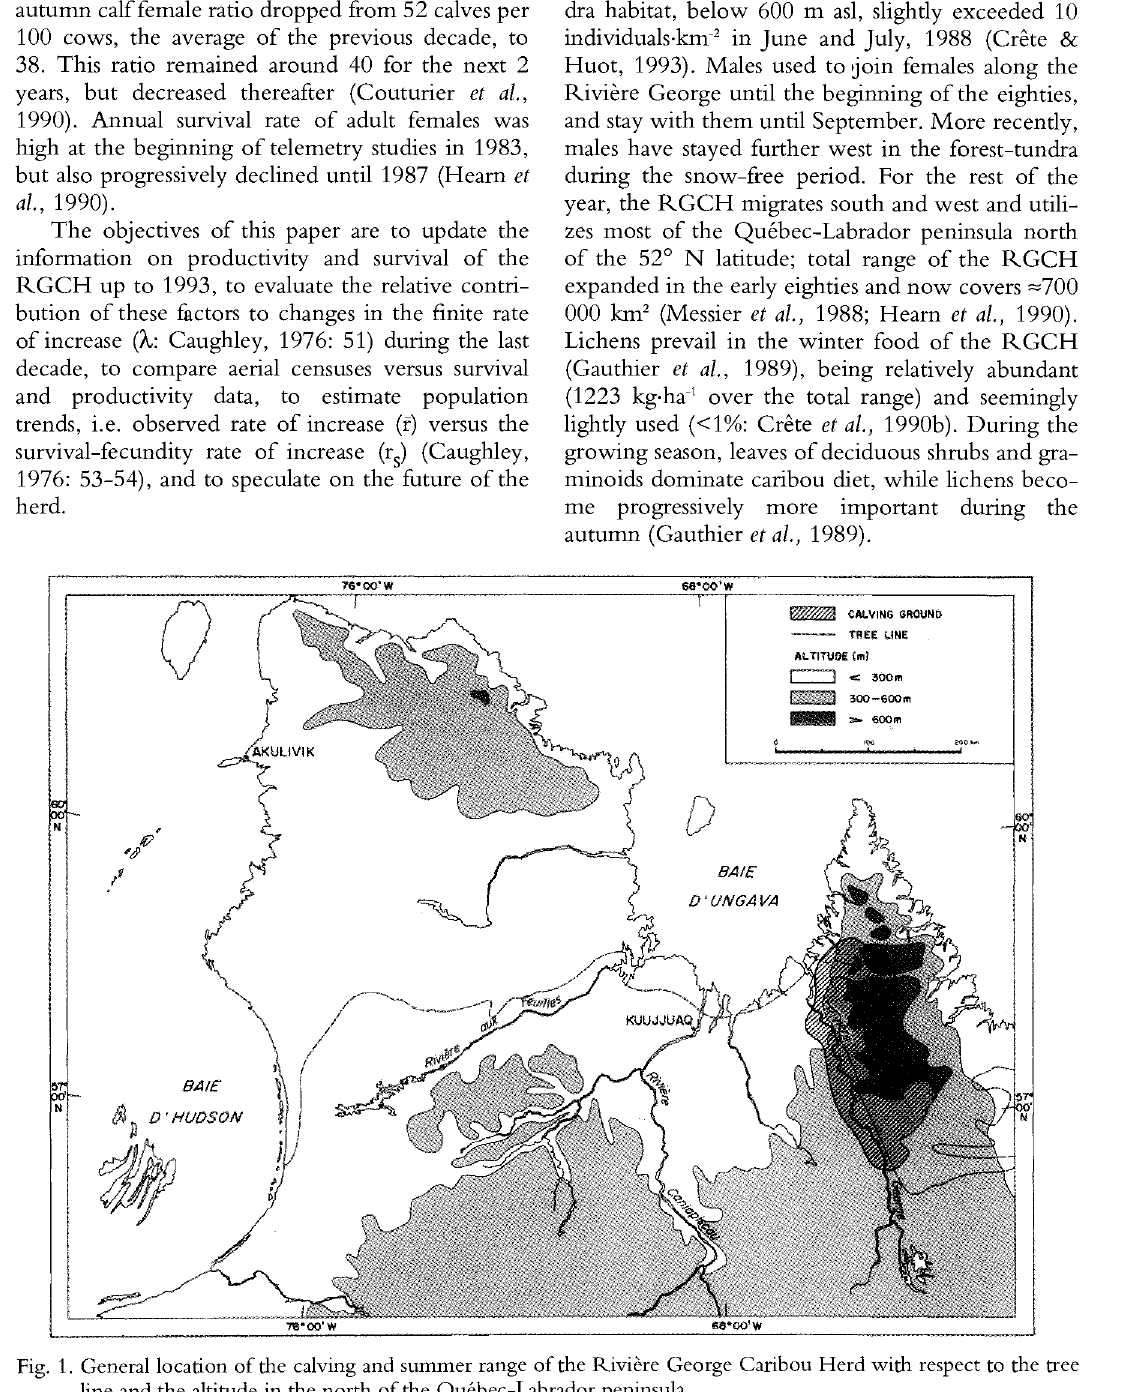
Fig. 1. General location of the calving and summer range of the Rivière George Caribou Herd with respect to the tree line and the altitude in the north of the Québec-Labrador